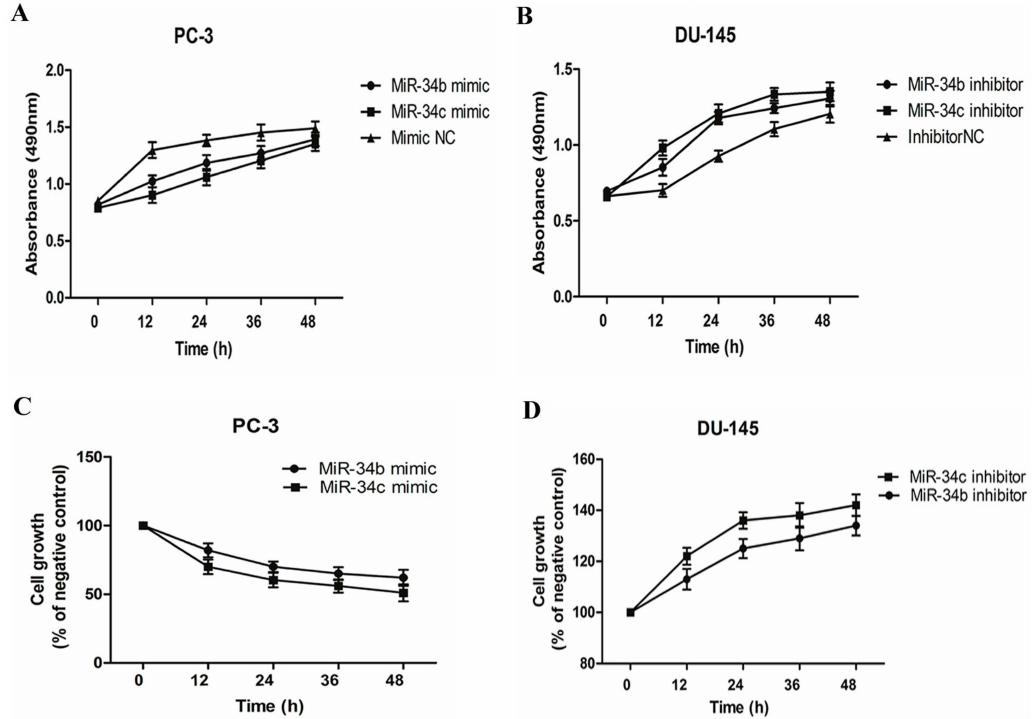
Figure 3. Both miR-34b and miR-34c suppresses prostate cancer cell proliferation. ( A , B ) 3-(4,5- dimethyl-2-thiazolyl)-2,5-diphenyl-2-H-tetrazolium bromide (MTT) assay of PC3 cells transfected with miR-34b/c mimic (50 nM) or mimic negative control (NC) (50 nM) and DU145 cells transfected with miR-34b/c inhibitor (100 nM) or inhibitor NC (100 nM); ( C , D ) Effects on cell growth with ectopic expression of miR-34b/c in DU145 and PC3 by live cells counting compared to the negative control. Per condition, three independent experiments were